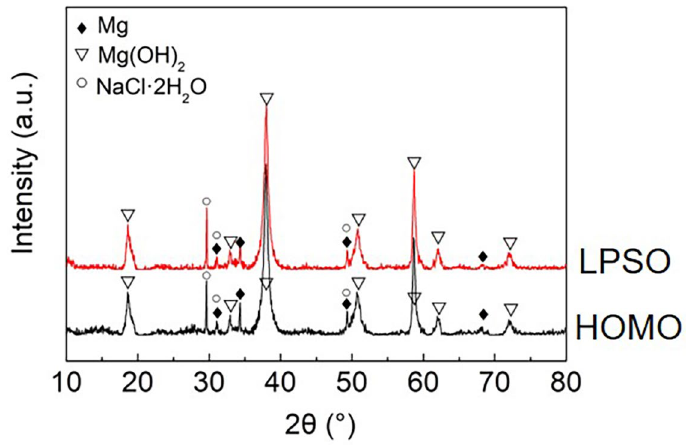
Figure 9. XRD patterns of the HOMO and LPSO samples after 24 h immersion.